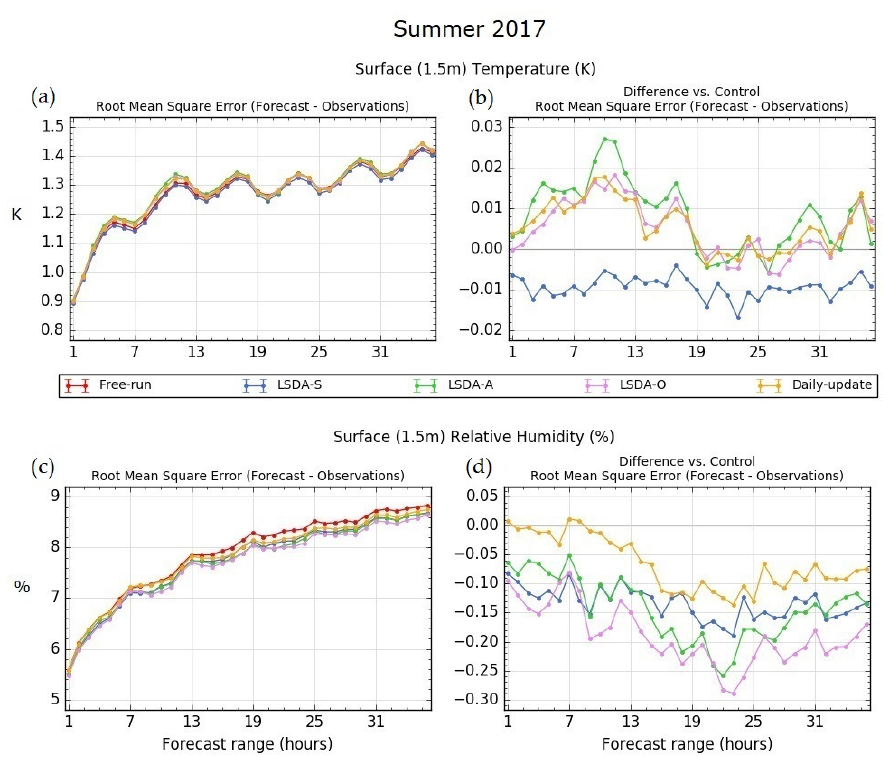
Figure 7. Summer forecast from 1 July 2017 to 31 August 2017 compared to observations. Root mean squared errors or RMSE in surface (1.5 m) temperatures (Kelvin) ( a ) and in relative humidity (%) ( c ) computed for UKV forecasts against ground-based SYNOP observations for all forecast ranges up to T + 36 h. Shown are the control run without LSDA or free-run (red), daily-update (yellow) and the experiments: assimilation of pseudo-observations of screen-level temperature and humidity only (blue), assimilation of ASCAT only (green) and assimilation of both observation types (pink). Panels ( b , d ) show the RMSE di ff erence between the free-run and each of the daily-updates and the three experiments, such that a negative result means improvement of the experiment over the free- run.